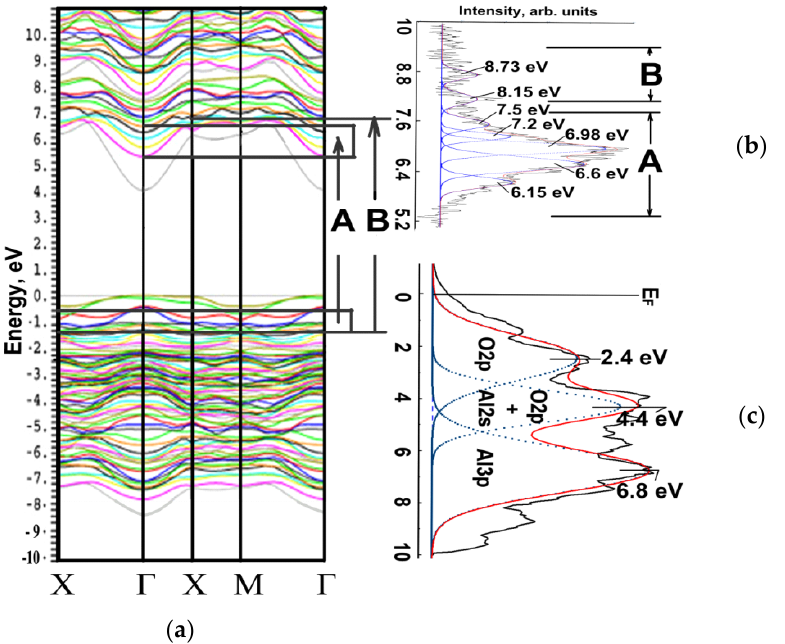
Figure 4. Interpretation of HREELS fine structure. Calculated density of states (DOS) of Al 2 O 3 ( a ) based on data from [32]; energy loss spectrum ( b ) and valence band ( c ) 20 nm layer of Al 2 O 3 .